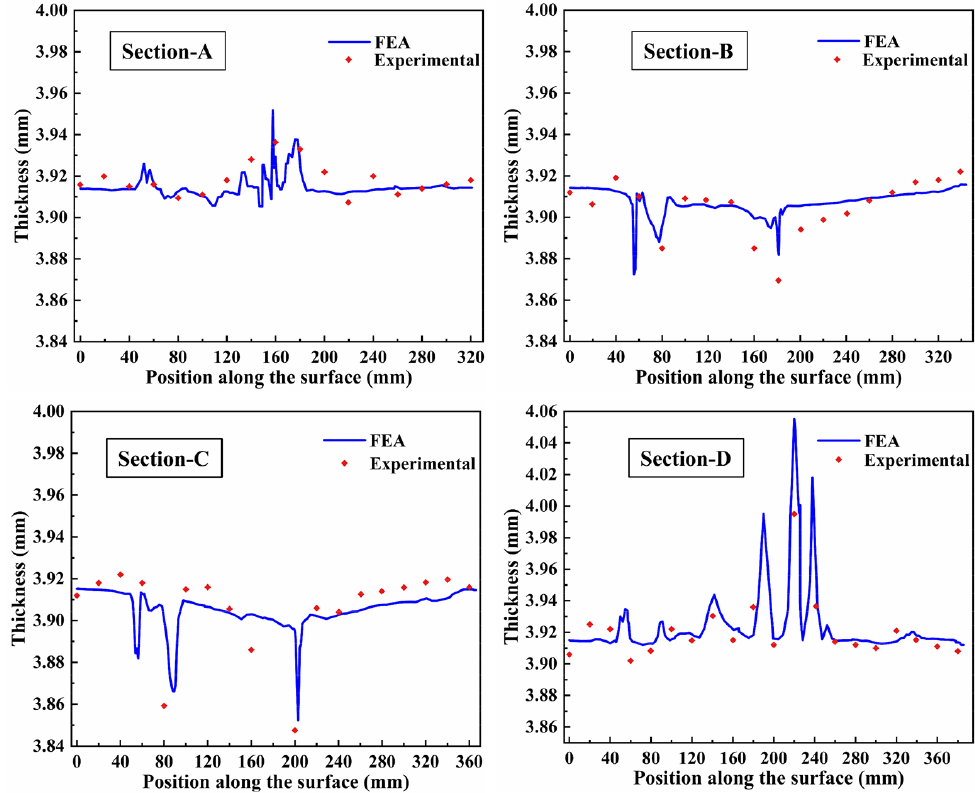
Figure 14. Comparison between simulation and experimental thickness distribution of the skin in each section.